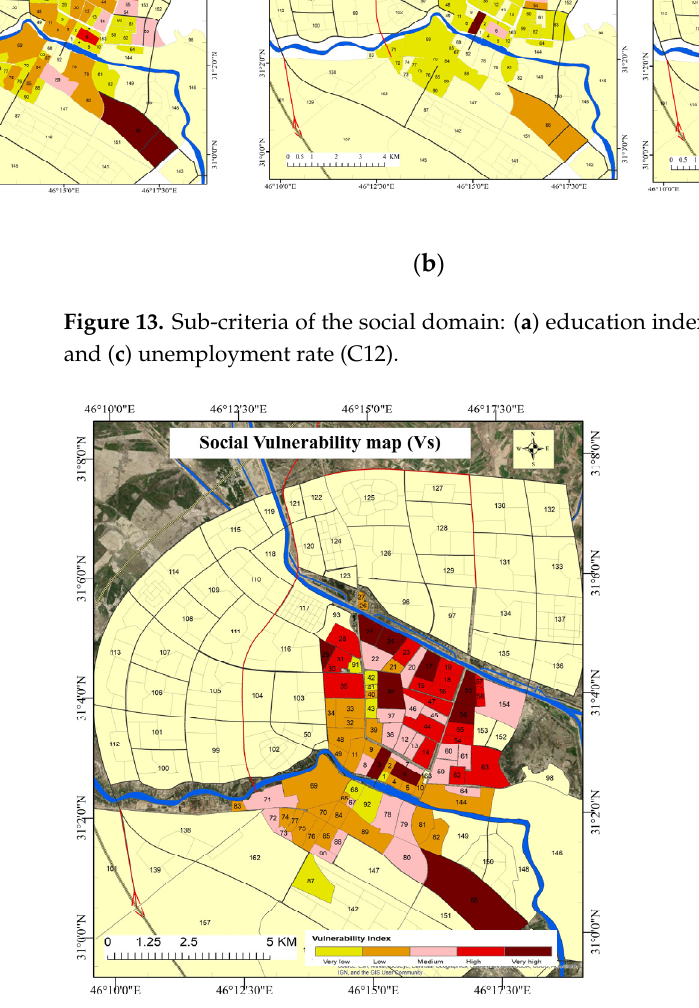
Figure 14. Social vulnerability map (Vs).